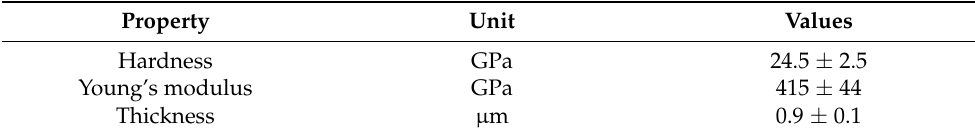
Table 5. Mechanical properties of a 3YSZ-titanium carbide (TiC) coating on WC-Co specimens.